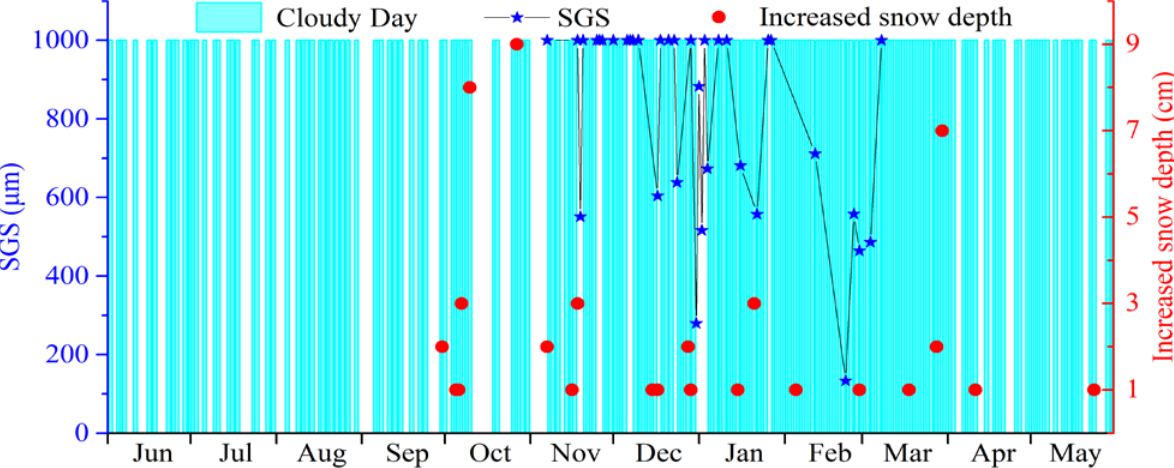
Figure 15. The MODIS-observed cloudy days, snow grain size, and in situ snow depth records at the Bayanbulak meteorological station for the 2017 hydrological